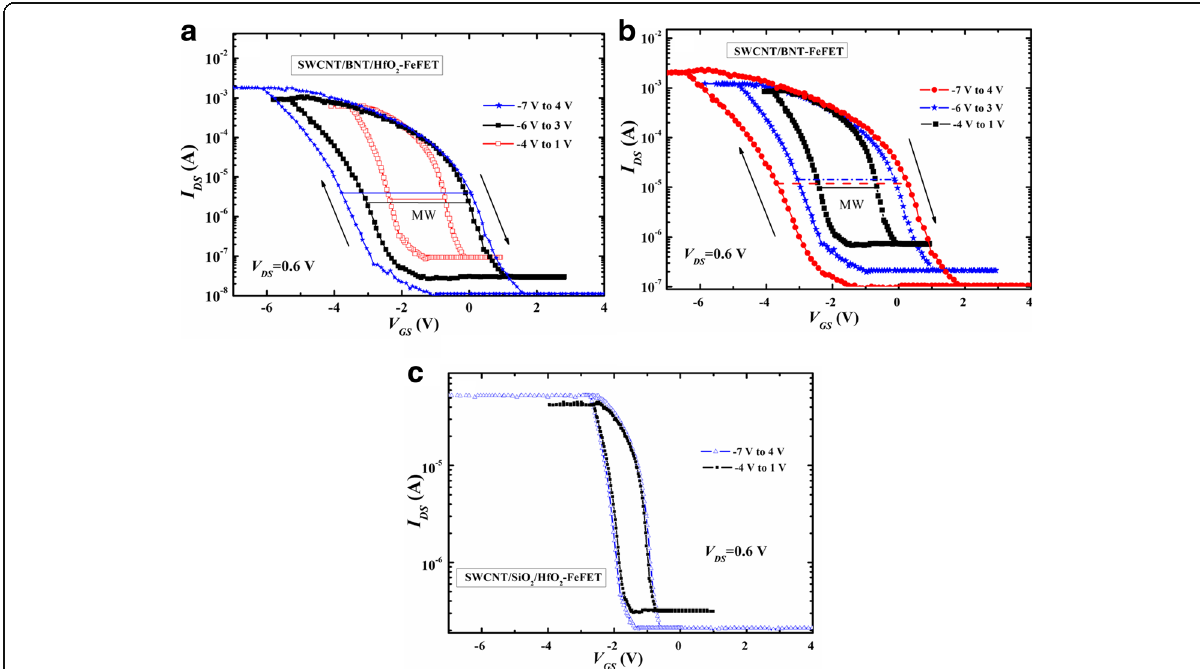
Fig. 5 Logarithmic transfer curves of stripe patterned a SWCNT/BNT/HfO 2 -FeFET, b SWCNT/BNT-FeFET, and c SWCNT/SiO 2 /HfO 2 -FET at V DS = 0.6 V . The arrows indicate an anticlockwise hysteresis loop, and the solid lines exhibit the width of memory window